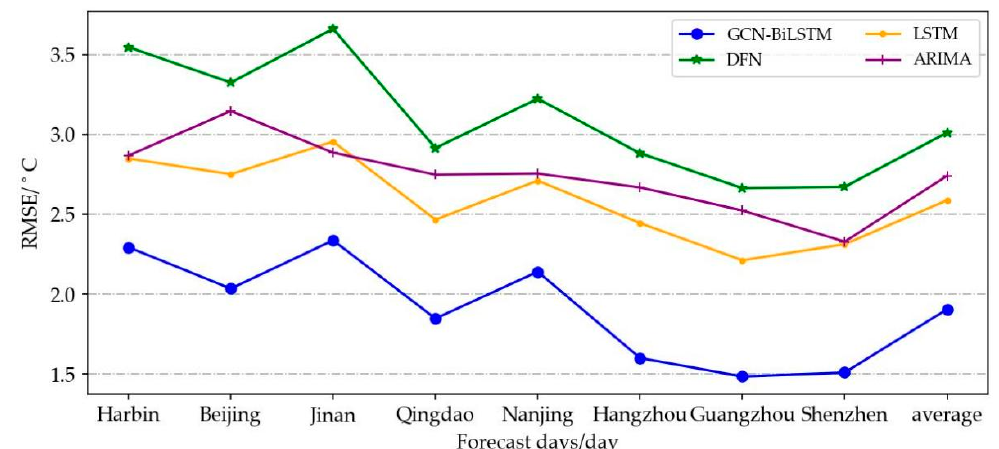
Figure 9. Comparison of RMSE of multiregional temperature prediction experiments.